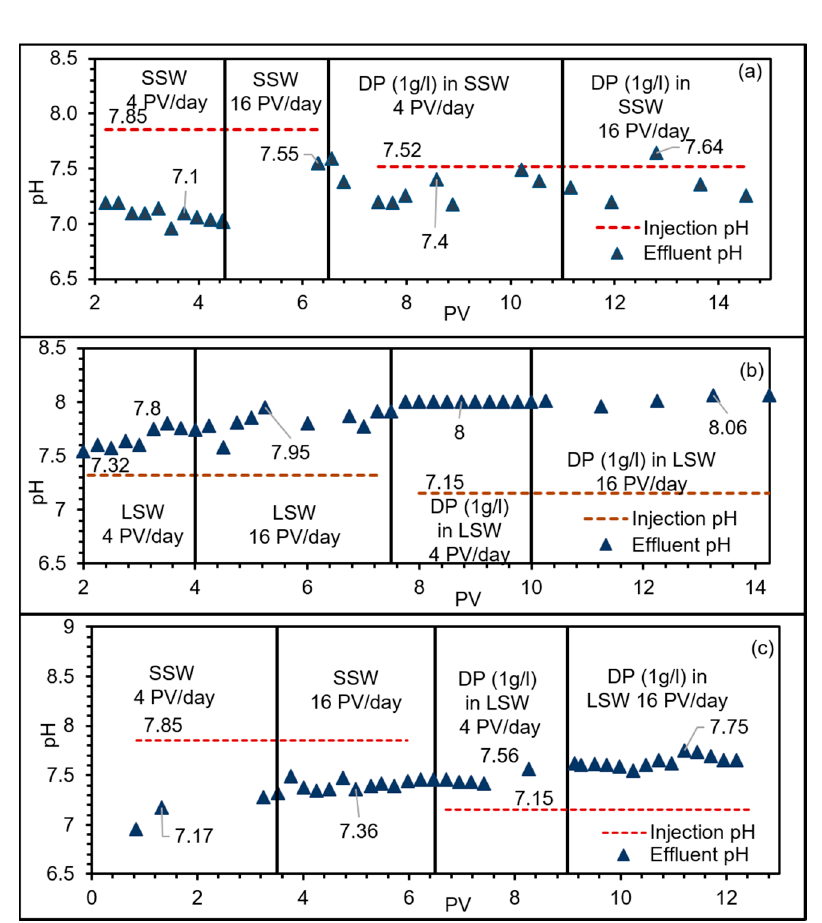
Figure 7. Effluent pH profiles for SK5-SSW ( a ), SK6-LSW ( b ) and SK7-mixed ( c ).